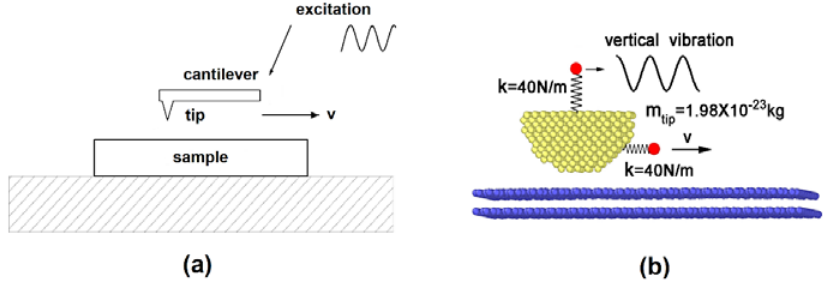
Figure 1. ( a ) A simplified schematic of a dynamic atomic force microscope, in which an excitation to the shaking piezo results in the tip’s oscillation. ( b ) Molecular dynamics (MD) model: the diamond tip on two layers of